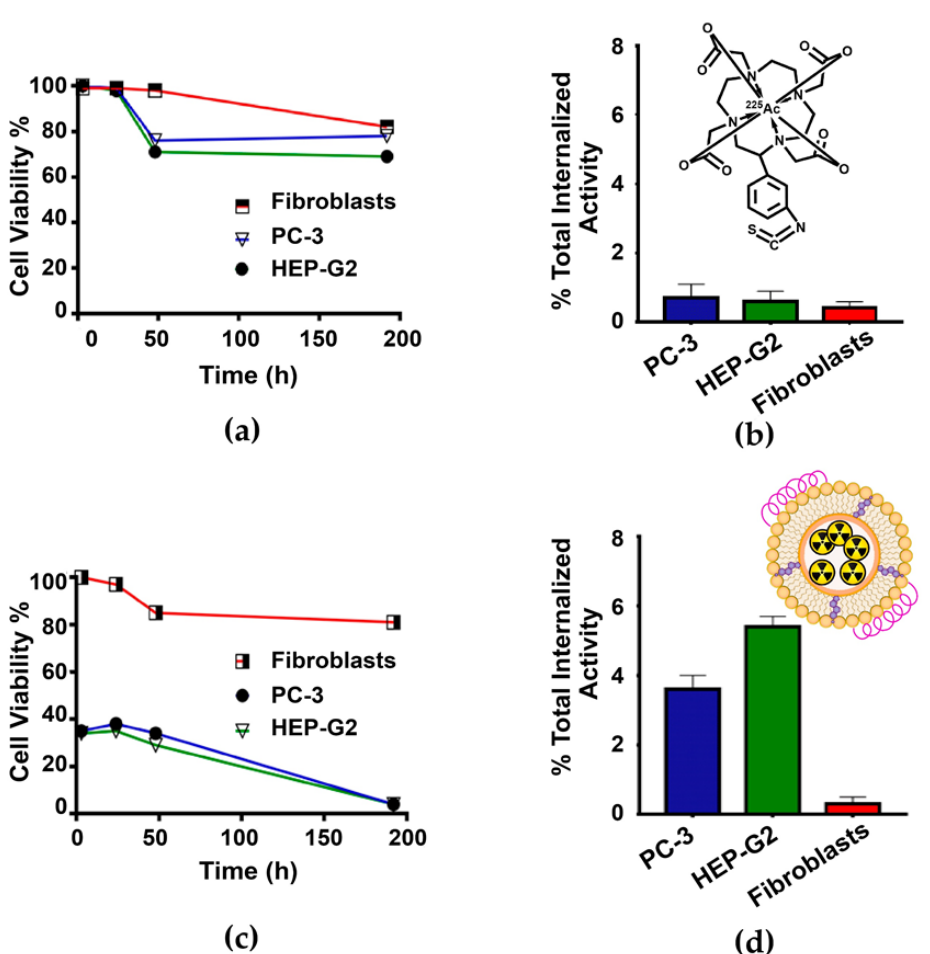
Figure 4. Cell viability assay: ( a ) PC-3, HEP-G2, and fibroblast cell lines treated with the 225 Ac-DOTA-benzene-p-SCN system (control); note that viability above 80% was maintained after 192 h for all cell lines. ( b ) Internalization of 225 Ac-DOTA-benzene-p-SCN in PC-3, HEP-G2 cells, and fibroblasts; note that the low cellular internalization of the 225 Ac-DOTA-benzene-p-SCN complex (without significant difference among cells, p > 0.05, two-way ANOVA) correlates with a relatively low effect on cell viability at 192 h. ( c ) PC-3, HEP-G2, and fibroblast cell lines treated with the 225 Ac-rHDL system; note a viability of 62–64% after 24 h and less than 3.5% at 192 h for the PC-3 and HEP-G2 cell lines, which overexpress the SR-BI protein. ( d ) Internalization of 225 Ac-rHDL in PC-3, HEP-G2 cells, and fibroblasts; note a significant cellular internalization of the 225 Ac rHDL complex in PC-3 and HEP-G2 cells, which correlates with a significant effect on cell viability.